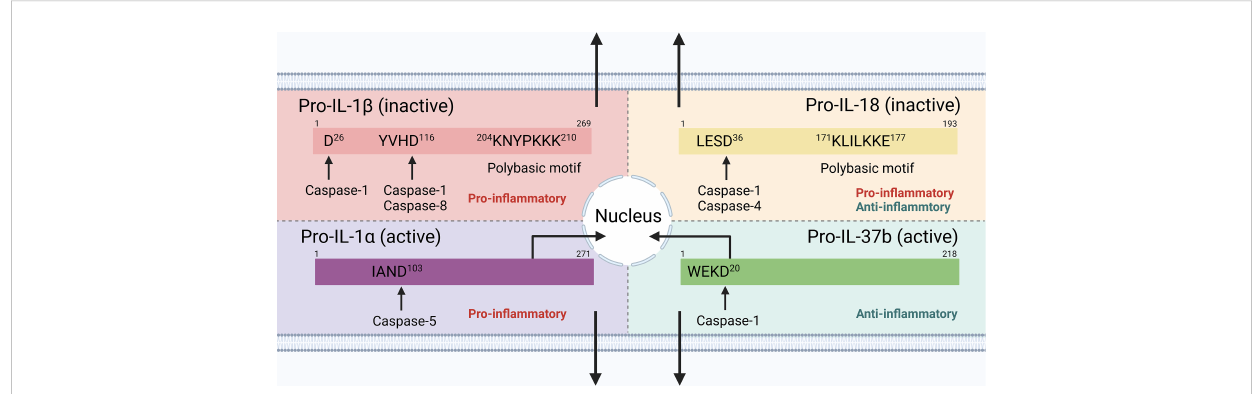
FIGURE 2 Cytokine processing downstream in fl ammasome signaling in human cells. IL-1 b and IL-18 precursors are inactive and require cleavage by caspase-1 into their mature forms; IL-1 a and IL-37 precursors are active, with mature forms that increase the biological activity and receptor af fi nity. IL-1 a